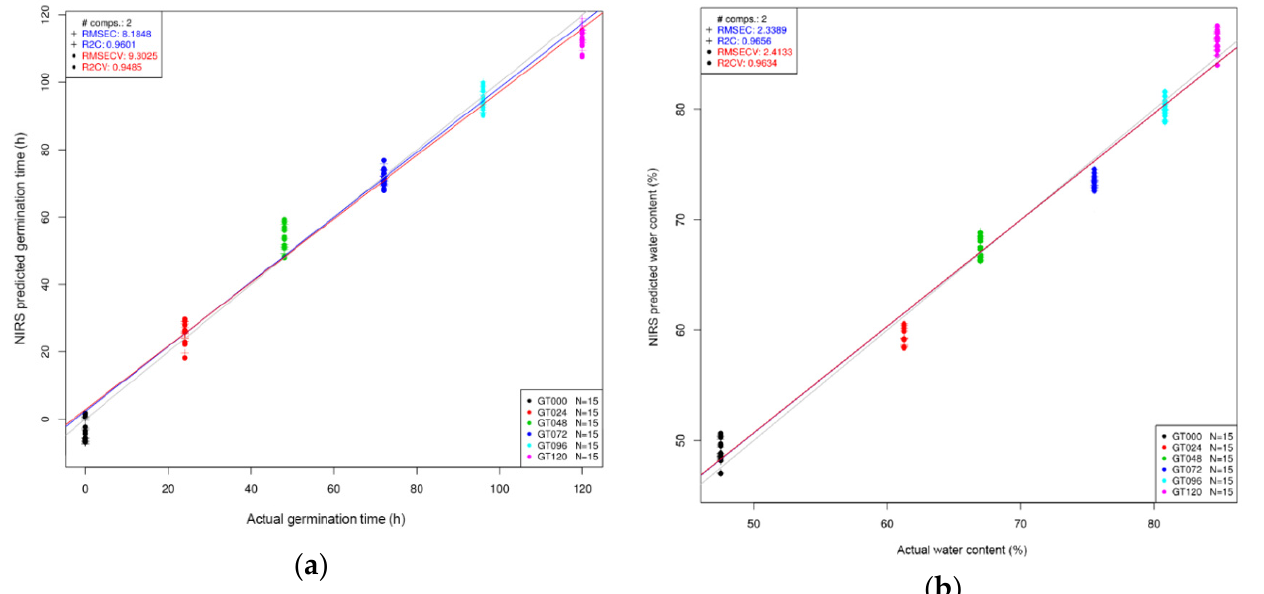
Figure 5. Partial least squares regression (PLSR) of bean sprout extract spectral data in the wavelength interval of 1300– 1600 nm, after Savitzky-Golay smoothing (SG) and standard normal variate (SNV) pretreatment of the spectra and 6-fold cross-validation method: ( a ) Regression based on germination time of the sprouts, and ( b ) regression based on the water content of the sprouts.